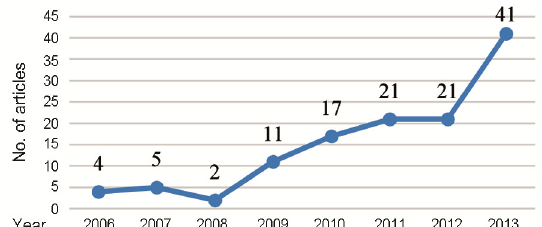
Fig. 1. Publications on IT in construction safety management The top ten countries from which the largest number